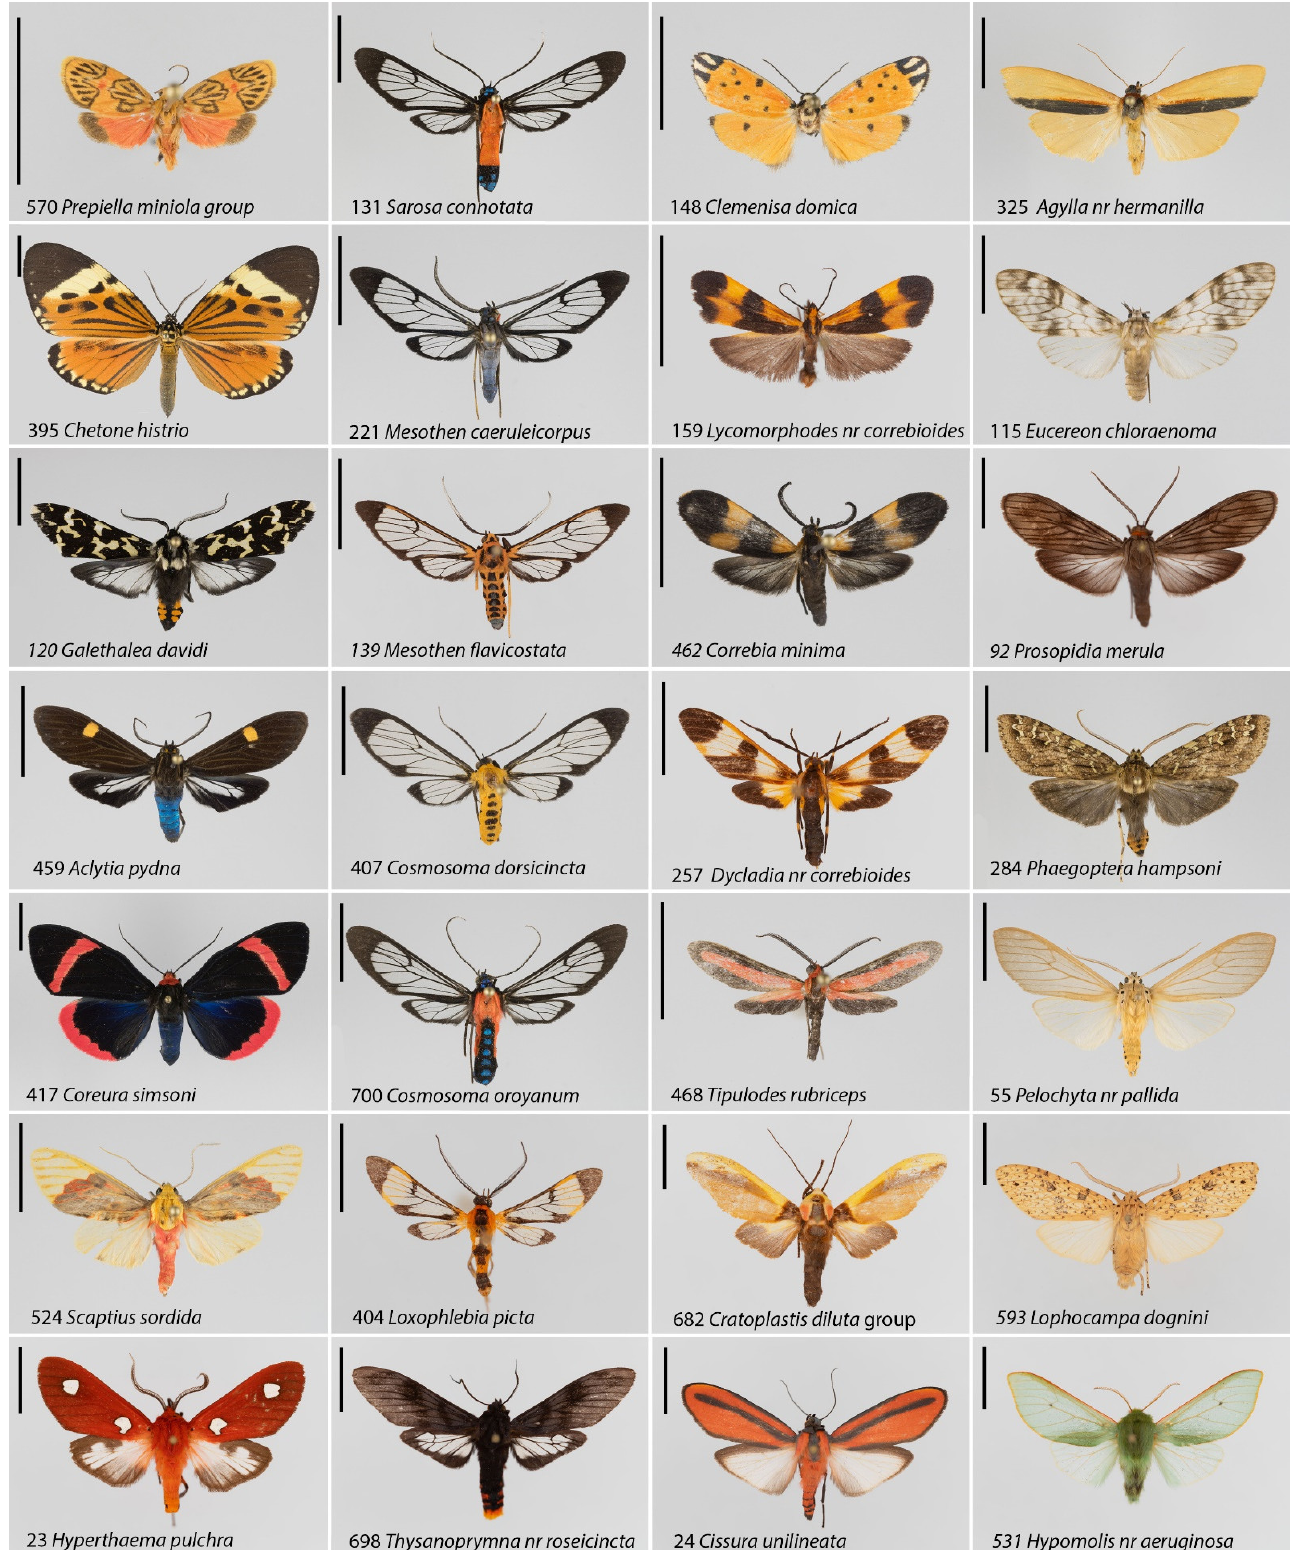
Figure 1. Twenty-eight exemplar species of Arctiinae species (with database numbers, as in Supplementary Table S1) from the Ecuadorian Andes, representing aposematic coloration (first column), hymenopteran mimicry (second column), beetle mimicry (third column) and cryptic appearance (fourth column). Scale bars: 1